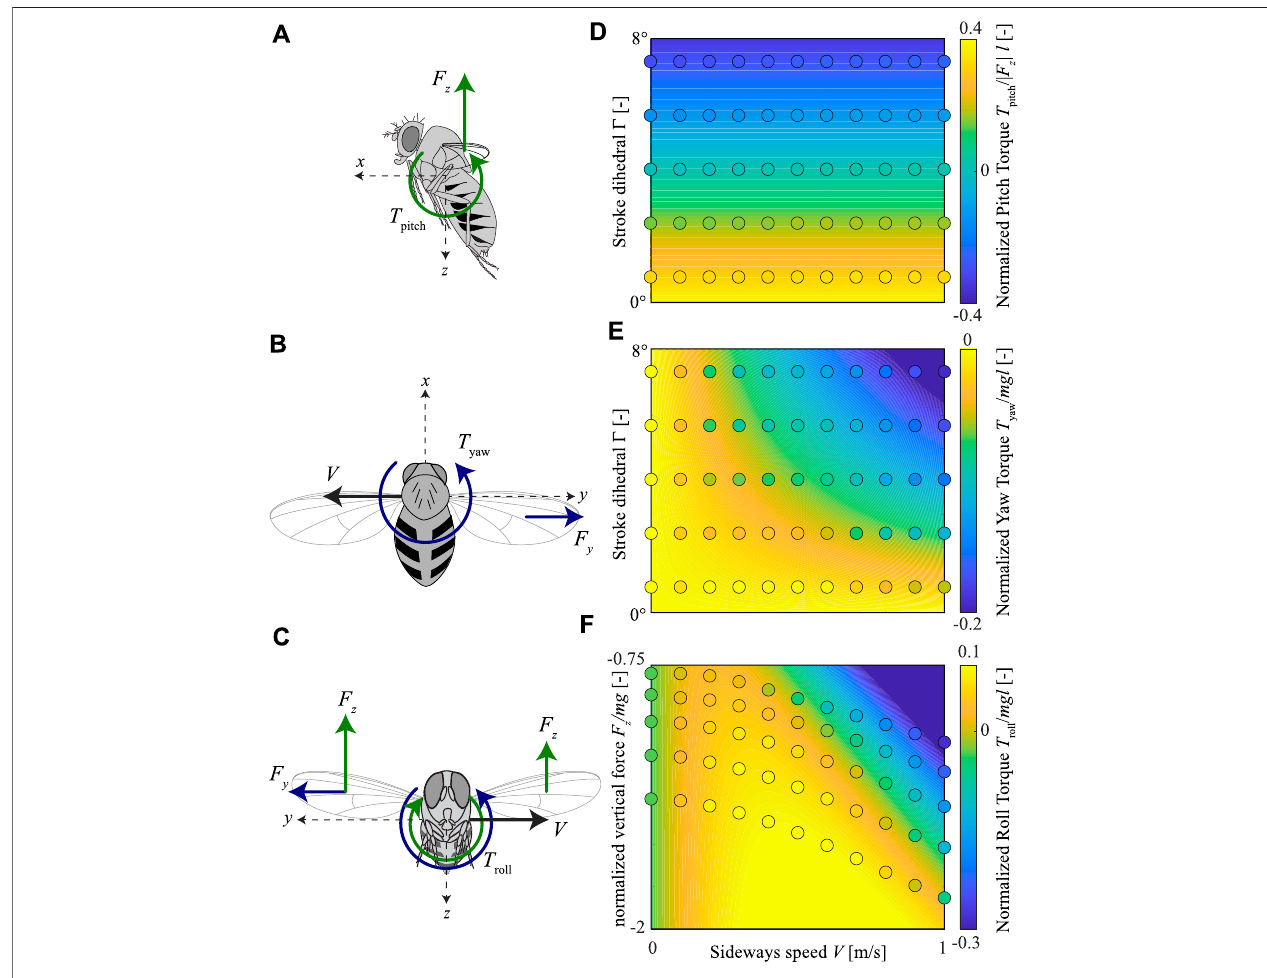
FIGURE 11 | Fit ofour proposed body torque model for sideways- fl ying fruit fl ies to the CFD data. (A – C) Free body diagrams of fruit fl ies fl ying sideways, including the pitch, yaw, and roll torques, respectively. (D – F) The pitch, yaw, and roll torques, respectively, within the parametric space of all CFD simulations. Each panel shows the normalized torques in colors (see color maps on the right), whereby the CFD simulation results are shown by circles and the model fi t is shown as contour plots. The parametricspace forpitchand yawtorquesconsistsofsideways fl ightspeed(abscissa)andthestrokedihedral angle(ordinate);fortherolltorques,theparametric spaceconsists ofsideways fl ight speed (abscissa)and theverticalaerodynamicforce (ordinate). Yaw and roll torques arenormalized withthe order-of-magnitude ofthe weight and size of an average fruit fl y, whereas pitch torques are normalized by the absolute of the vertical aerodynamic force (| F z |) and the average size of a fruit fl y.